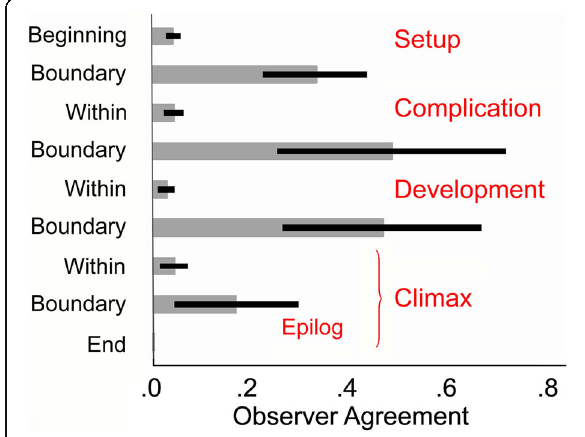
Fig. 4 Gray bars show the mean interobserver correlations in segmentation performance at nine sections pooled across the seven movies: (1) at all scenario entry boundaries before the end of the setup, (2) at the setup/complication scenario boundary, (3) at all scenario boundaries within the complication, (4) at the complication/ development boundary, (5) at all boundaries within the development, (6) at the development/climax boundary, (7) at all boundaries within the climax before the epilog, (8) at the epilog boundary, and (9) at all scenario boundaries after the beginning of the epilog. Black ribbons indicate the 95% confidence